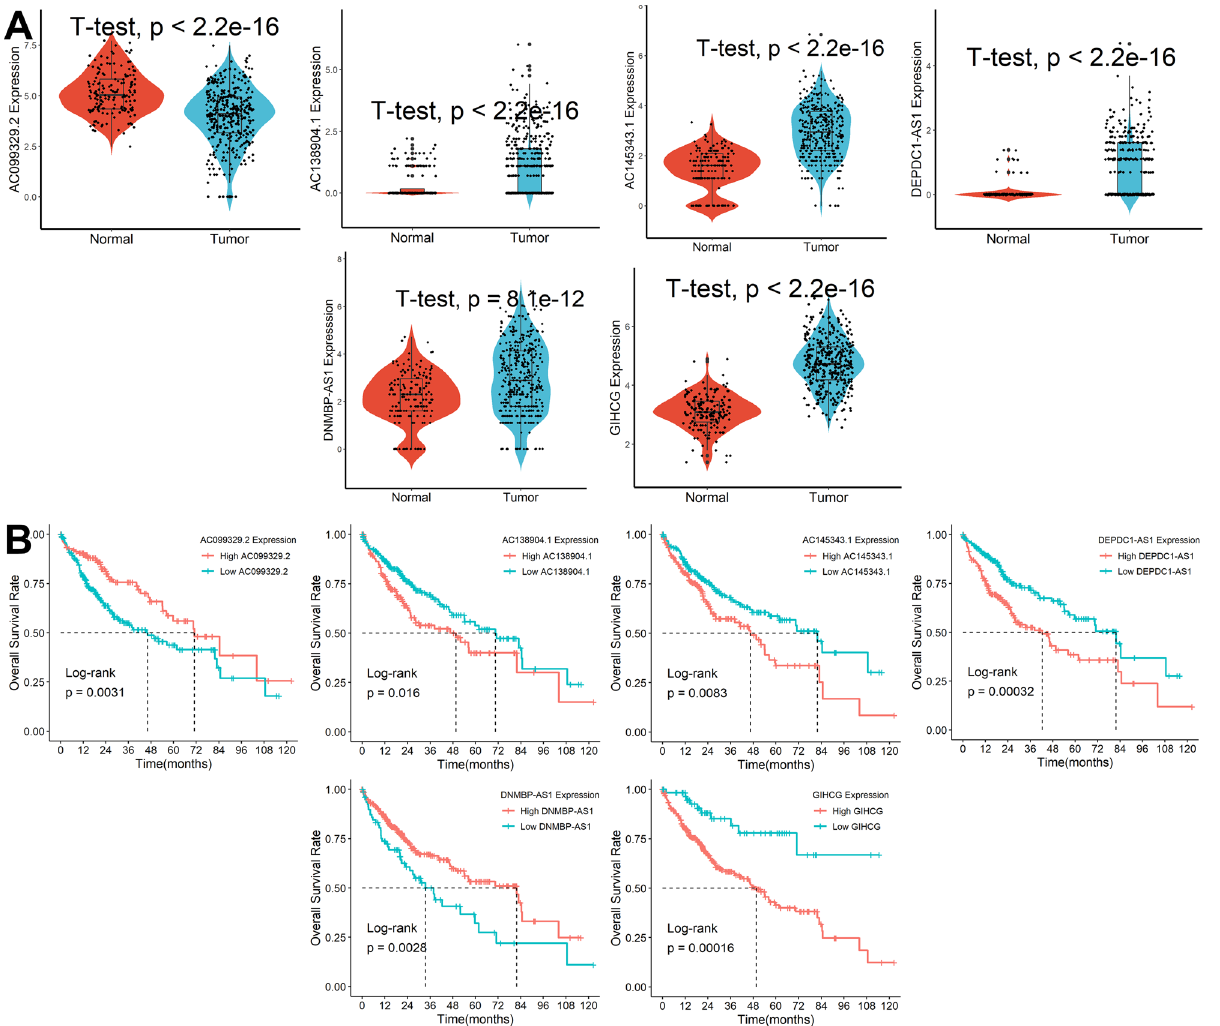
Figure 3. Expression and prognostic significance of the 6 lncRNAs. ( A ) Expression levels in tumor and normal tissues. ( B ) Prognostic value